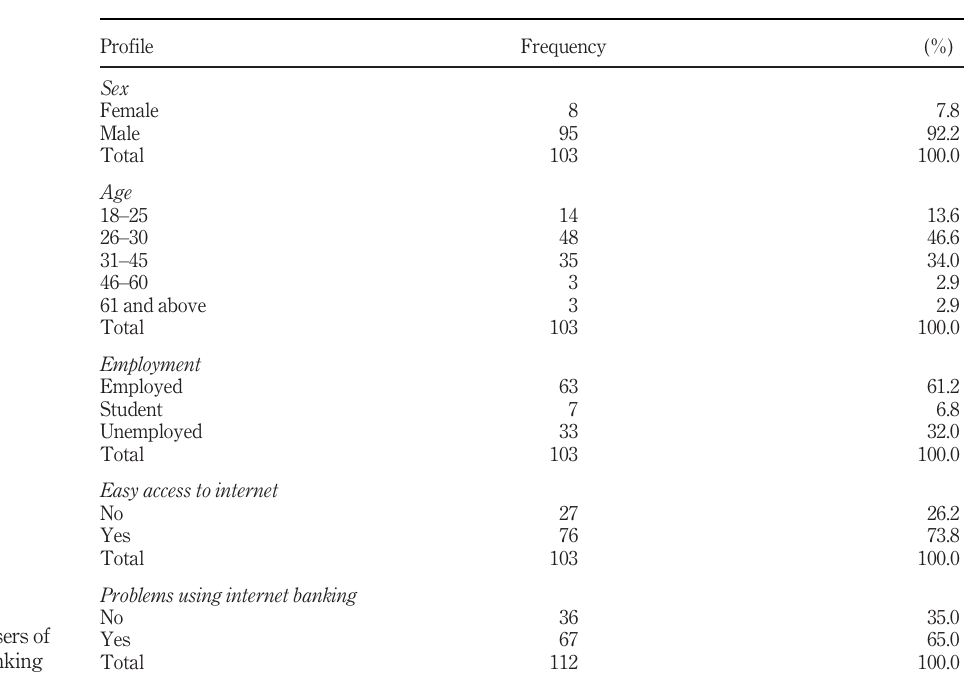
Table 2. Pro fi le of users of internet banking